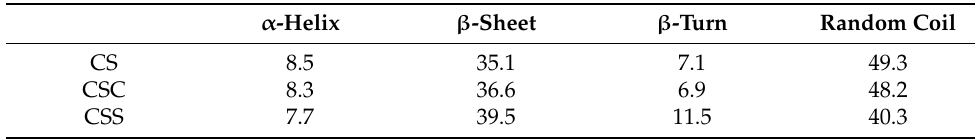
Table 5. Different secondary structure contents of CS, CSC and CSS. α -Helix β -Sheet β -Turn